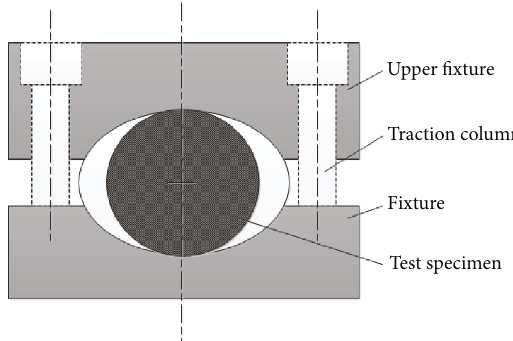
Figure 1: Diagram of rock and experimental